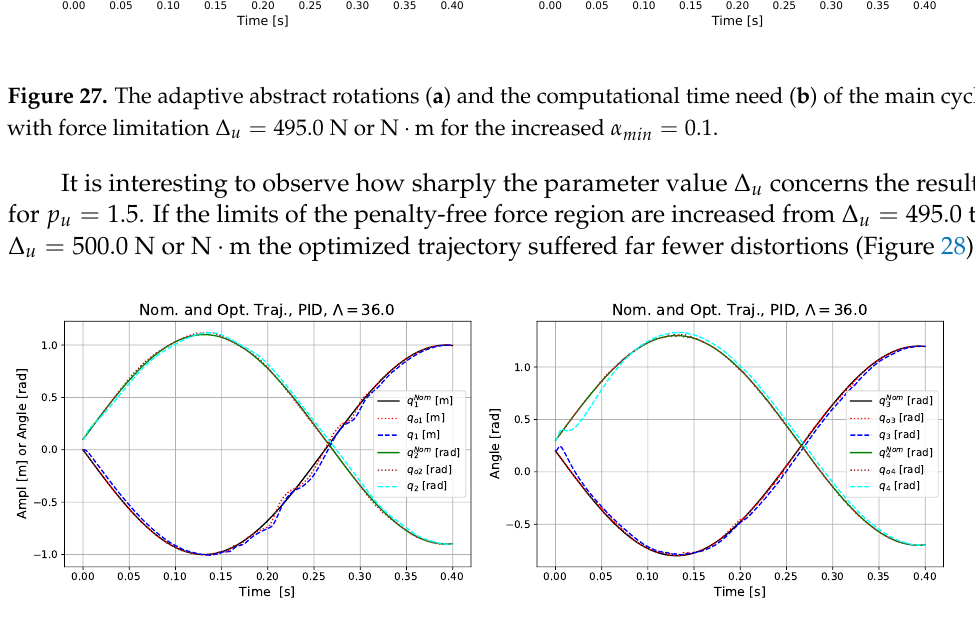
Figure 28. Trajectory tracking with force limitation ∆ u = 500.0 N or N · m for the increased α min = 0.1: ( a ) For q 1 and q 2 . ( b ) For q 3 and q 4